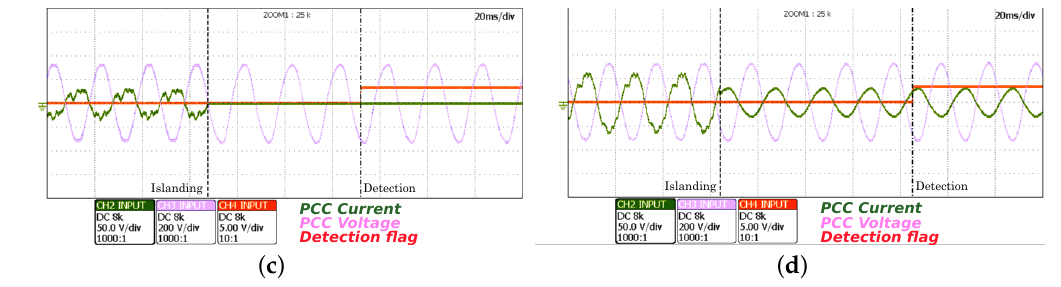
Figure 22. Experimental results under non-zero power flow. ( a ) Zero power injection and 4.6-kW resonant load per phase. ( b ) Two-kilowatt power injection and 4.6-kW resonant load per phase. ( c ) Five-kilowatt power injection without local load. ( d ) Ten-kilowatt power injection and 4.6-kW resonant load per